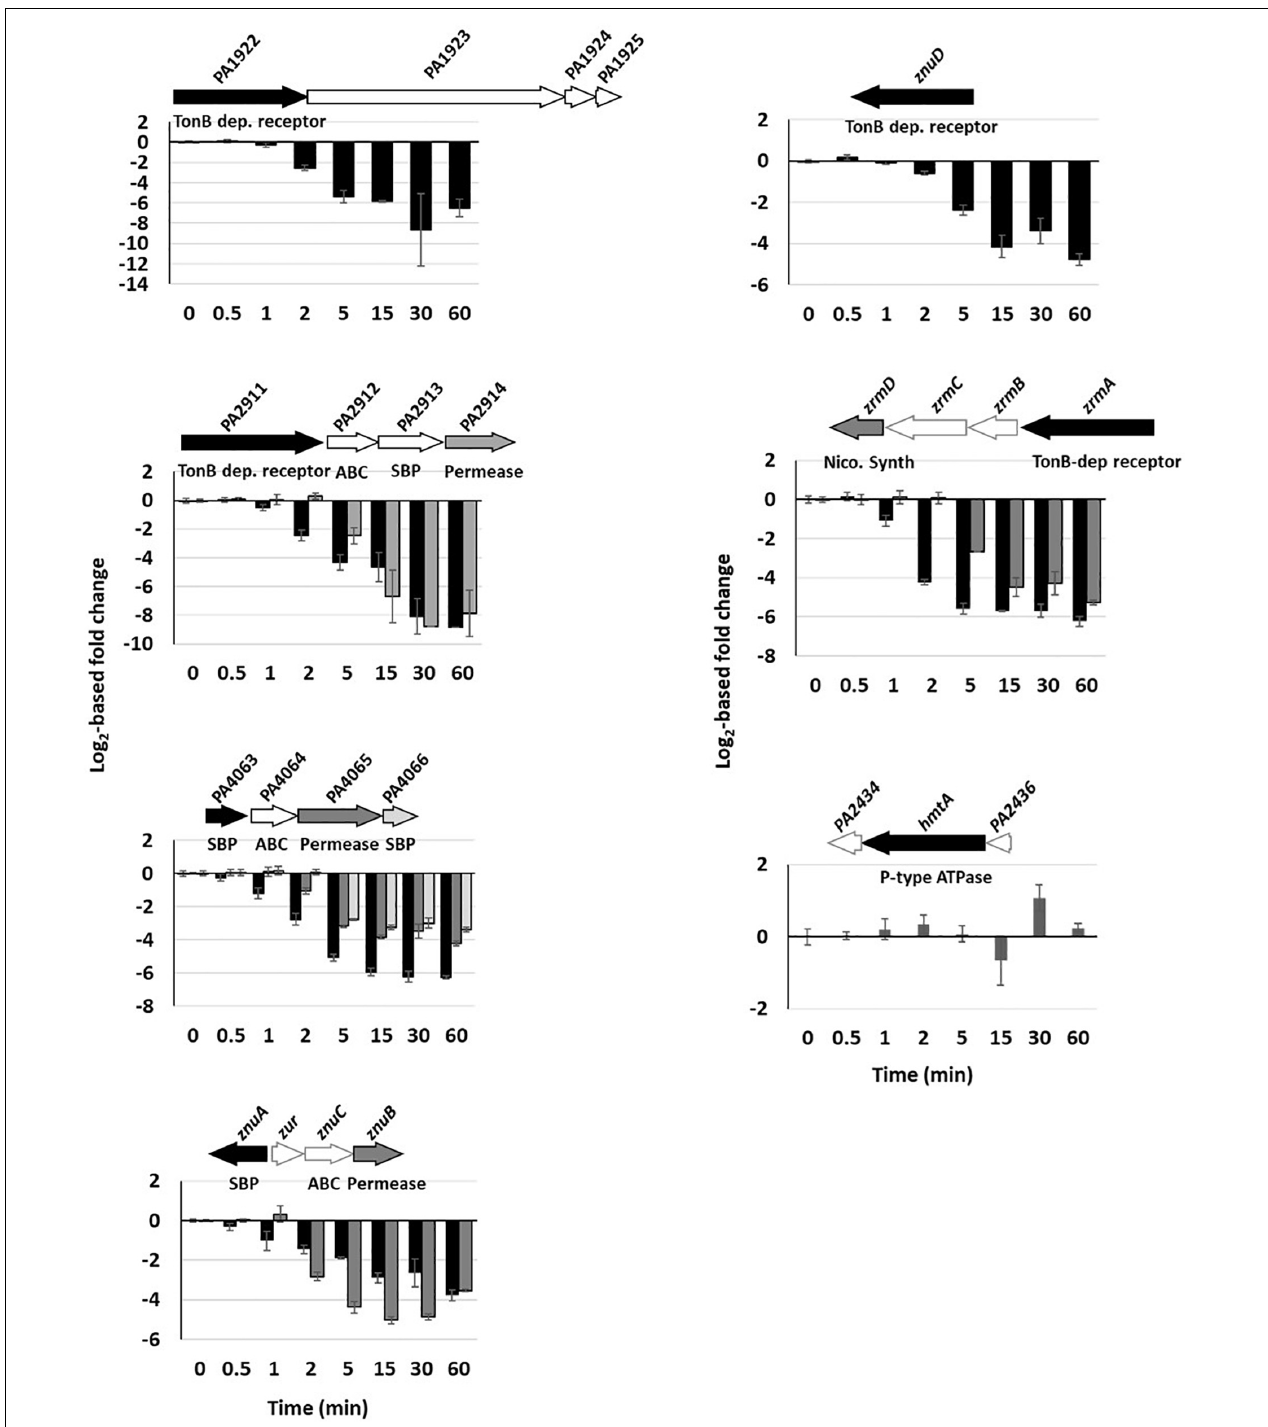
FIGURE 4 | Repression of Zn import systems. The fold change of gene repressions over time of the seven import systems are shown. Fold change of the copy number of transcripts measured using the NanoString technology before and after addition of 2 mM ZnCl 2 and monitored over time. Black, dark and clear gray in the histogram correspond to the followed gene in the genomic arrangement represented next to the graph. White arrows represent genes of the system that were not followed during this work. The fold repression gives a p -value ≤ 0.001 between 2 and 5 min after addition of Zn for all systems, except hmtA for which no repression was